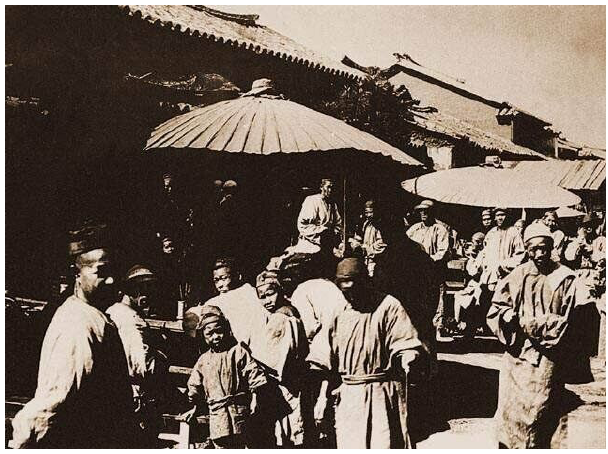
Figure 1. Nanqiang Street, Late Qing